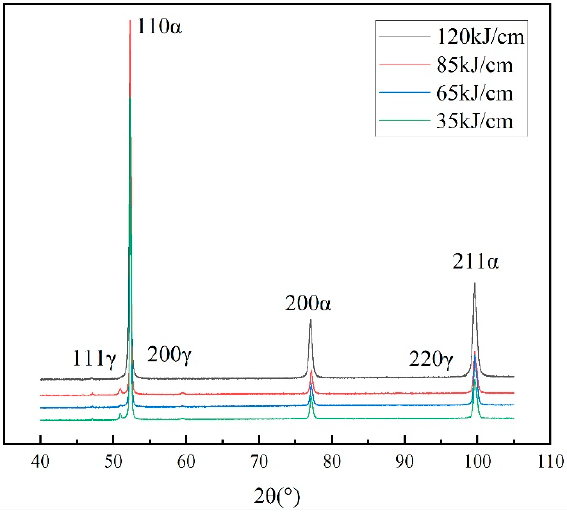
Figure 8. XRD spectra of the samples with different heat inputs from 120 to 35 kJ/cm. The changes in the reverse polarity diagram of each sample are shown in Figure 9. The inverse pole figures of microstructure in CGHAZ, where the high-angle grain boundaries (HAGB) with an MTA higher than 15 ◦ ( θ > 15 ◦ ) is represented by black lines, and the low-angle grain boundary (LAGB) with an MTA varied from 2 to 15 ◦ (2 ◦ ≤ θ ≤ 15 ◦ ) is represented by white lines. The percentage of low-angle grain boundaries 2 ◦ ≤ θ ≤ 15 ◦ ( f 2 ◦ ≤ θ ≤ 15 ◦ ) and the corresponding MED are listed in Table 2. When the heat inputs grad- ually decreased from 120 to 35 kJ/cm, f 2 ◦ ≤ θ ≤ 15 ◦ gradually increased. When the heat input steadily decreased from 120 to 65 kJ/cm, MED defined by the MTA lower than 15 ◦ decreased from 24.48 to 2.83 µ m. With a gradual decrease in the heat input from 65 to 35 kJ/cm, when MTA varied from 2 to 15 ◦ , MED sharply increased from 2.83 to 4.88 µ m. As Figure 9e,f shows, the grain size of IGAF at heat input of 65 kJ/cm was significantly refined compared with that of GB at heat input of 35 kJ/cm. Figure 10 shows MED for the misorientation tolerance angle (MTA) in the range of 2–30 ◦ and varying with heat input; the MED increased monotonically with the increase of MTA and heat input,